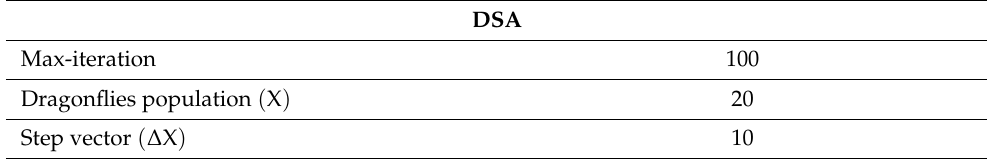
Figure 5. Flowchart of DSA. The initializing parameters of the DSA are defined in Table 1. The parameter values for various controllers are demonstrated in Table 2. Table 1. DSA initializing